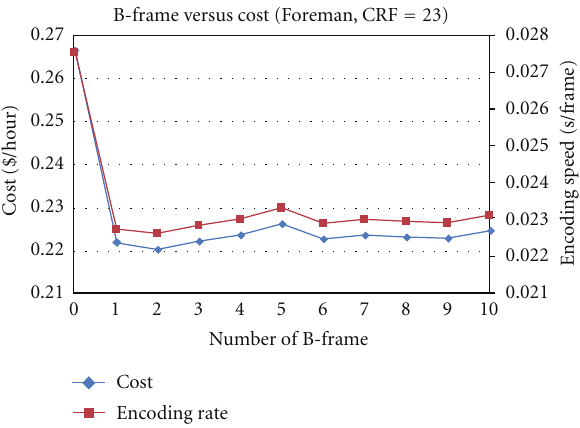
Figure 3: Cost and encoding speed with varying B-frame number (Foreman, crf = 23).